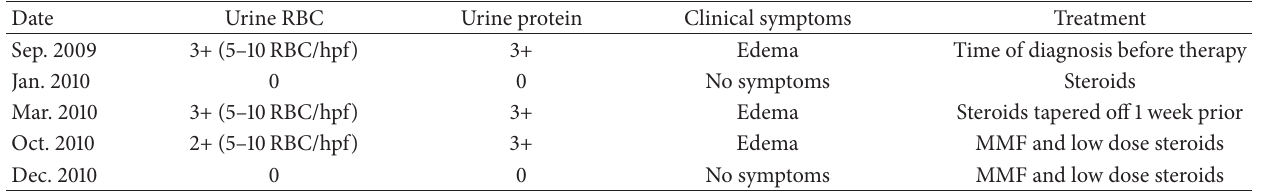
Table 1: Laboratory data and clinic